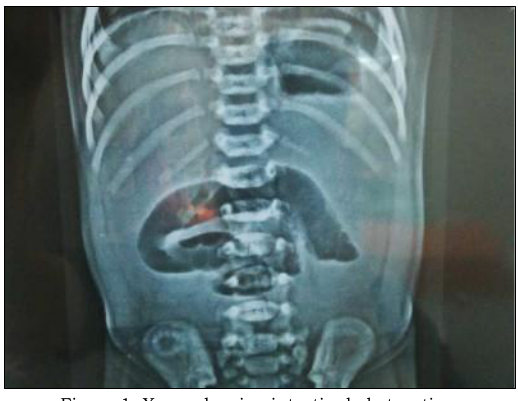
Figure 1: X-ray showing intestinal obstruction The baby was admitted, and a nasogastric tube was passed which yielded greenish aspirate. X-ray